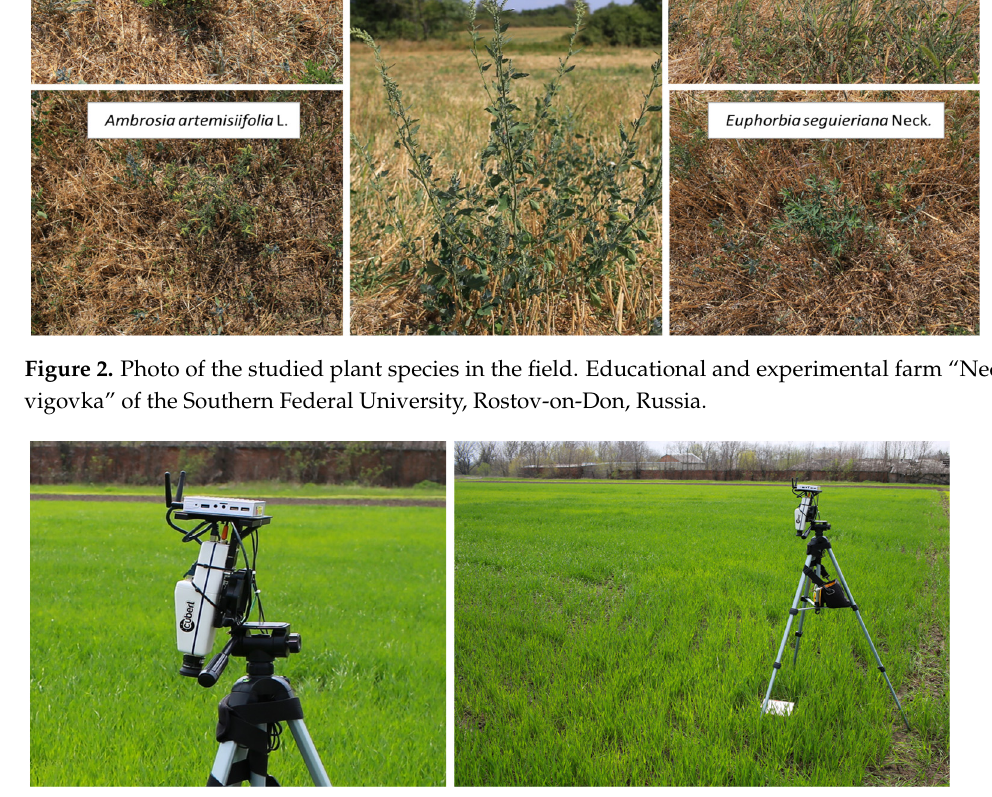
Figure 3. Collecting spectral characteristics of weed plant species ( right ) using a Cubert UHD 185 hyperspectral camera ( left ). Table 1. Characteristics of the Cubert UHD 185 hyperspectral camera.